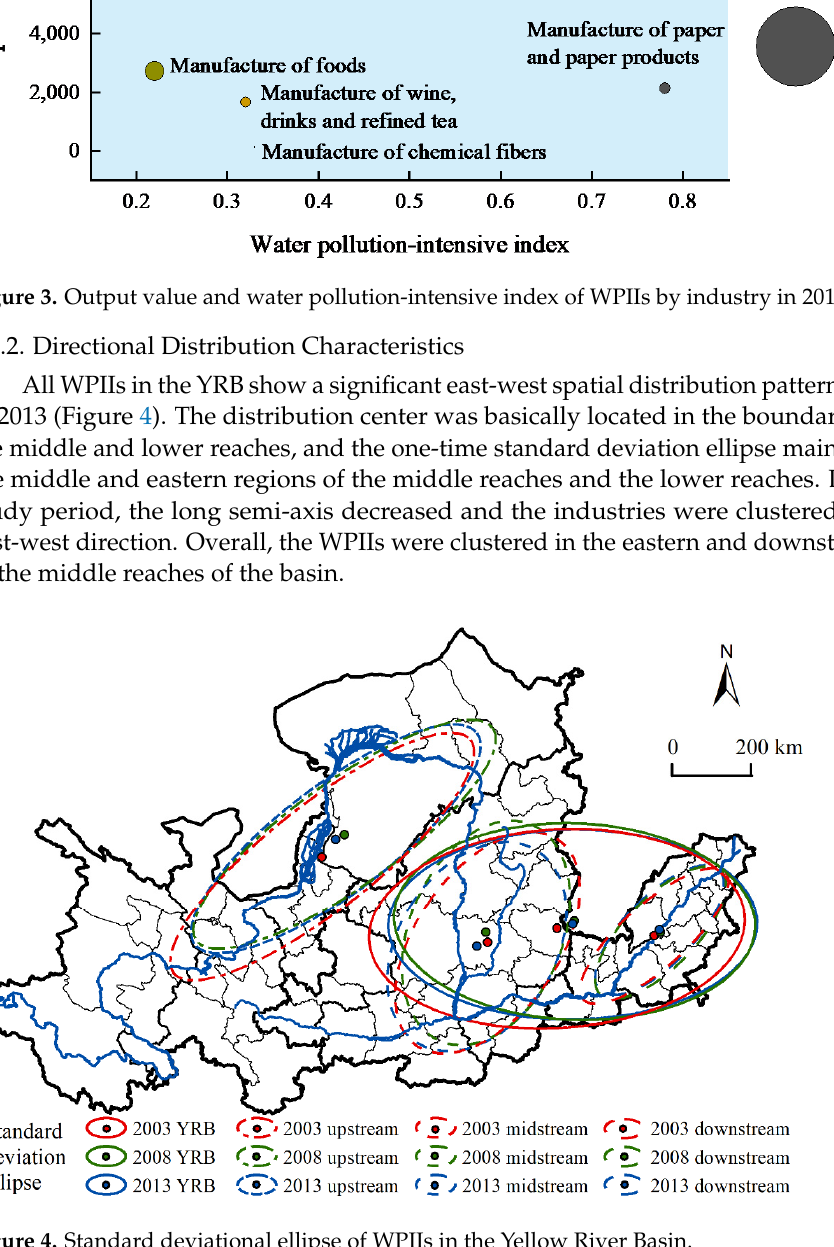
Figure 4. Standard deviational ellipse of WPIIs in the Yellow River Basin. Within the basin, the distribution directions of WPIIs in the upper, middle and lower reaches of the basin from 2003 to 2013 were similar, with an overall northeast-southwest direction (in the direction of the main tributaries of the Yellow River) and a symmetrical distribution along the river. In the upstream, the central axis of the industry was in